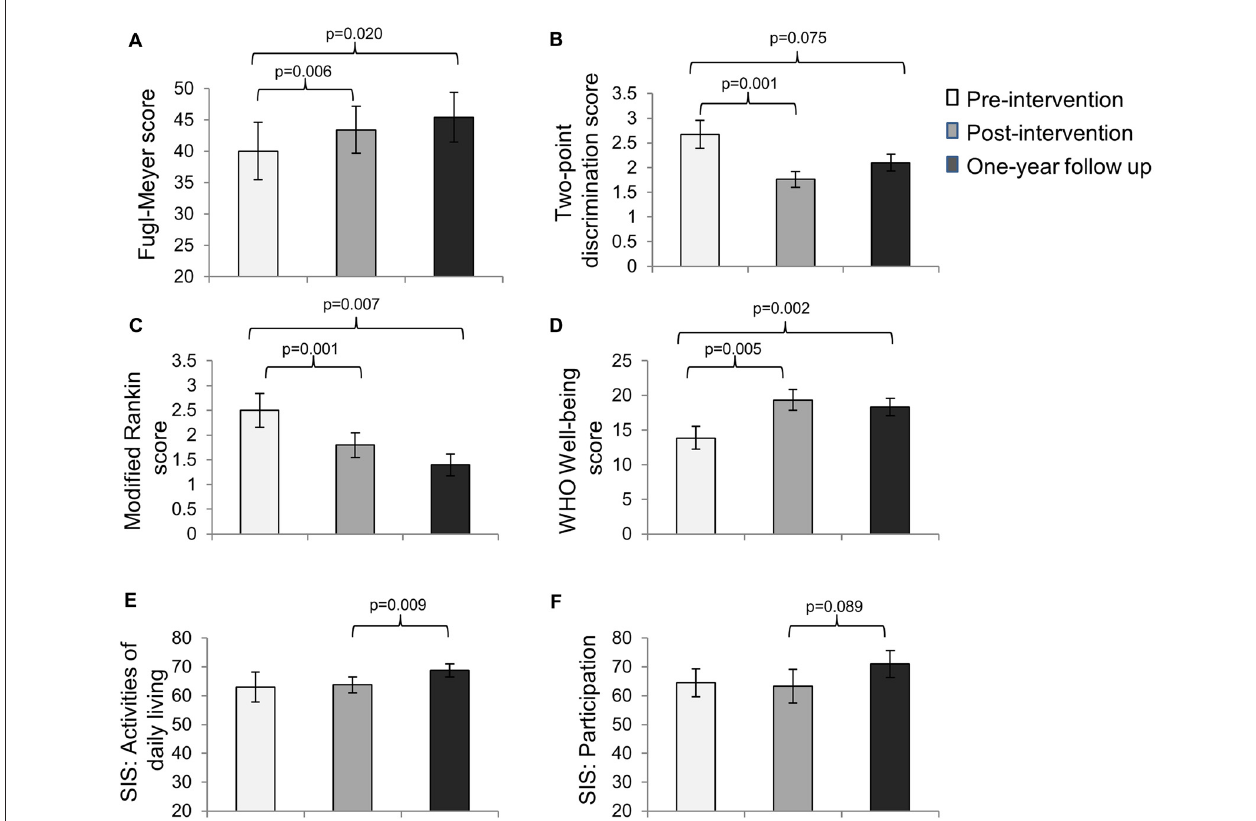
FIGURE 1 | Mean scores ( ± SE) on the (A) Fugl-Meyer Scale (FMS; n = 10), (B) Two-point Discrimination test ( n = 7), (C) Modified Rankin Scale (MRS; n = 10), (D) the WHO Well-being scale ( n = 9), (E) the activities of daily living subscale of the Stroke Impact Scale (SIS; n = 10) and (F) the participation subscale of the SIS ( n = 10) at pre-intervention, immediate post-intervention and 1-year follow up assessments.